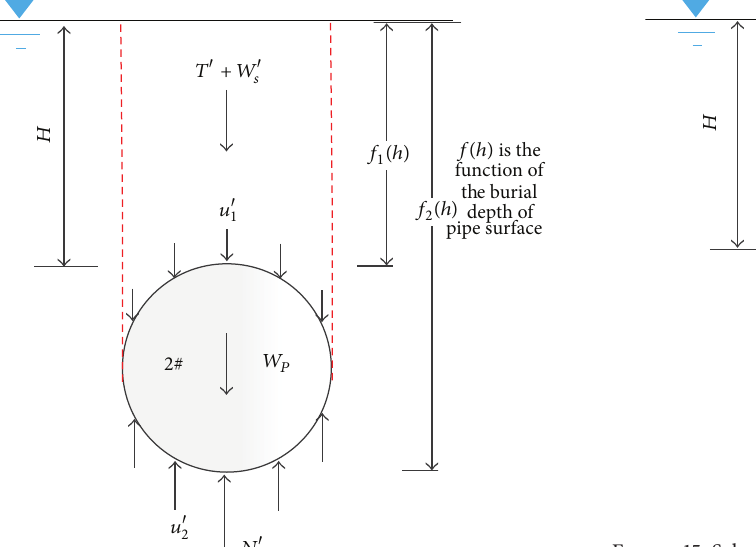
Figure 15: Schematic diagram of force of pipe 1# during